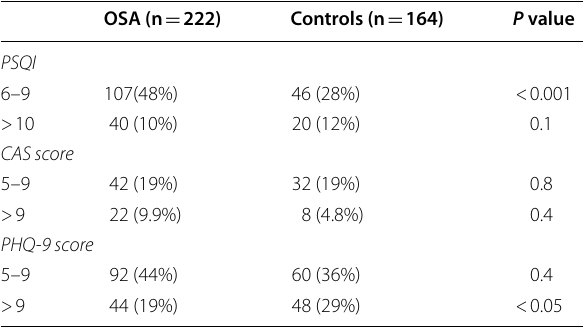
Table 3 Subgroups data for PSQI, CAS and PHQ-9 score